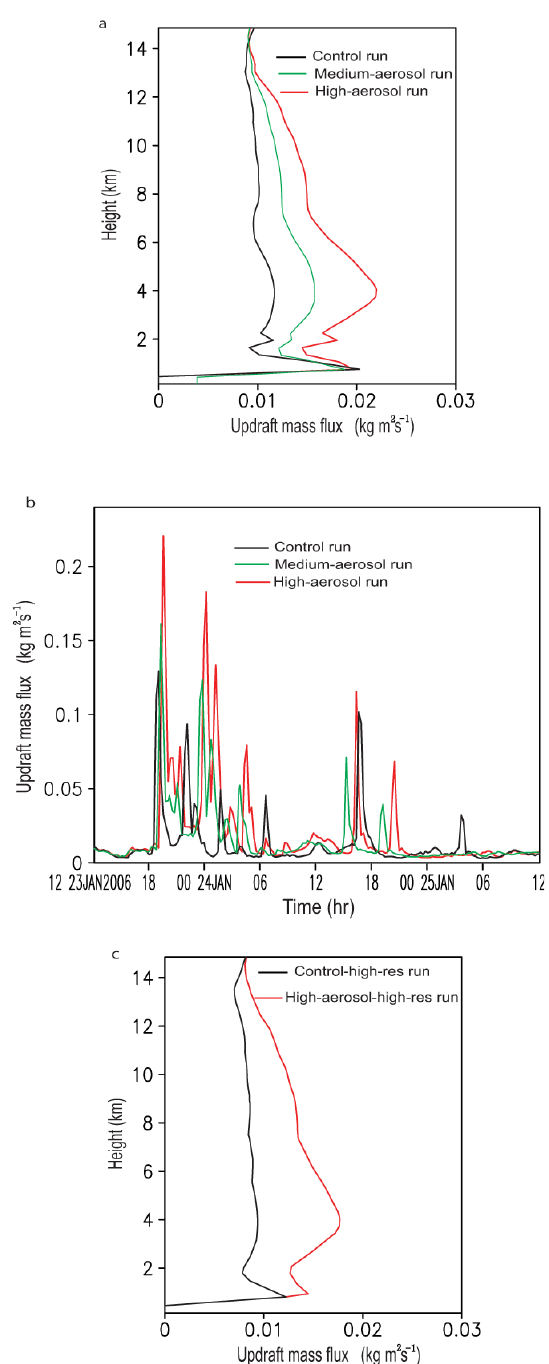
Fig. 2. (a) Vertical distribution of updraft mass fluxes and (b) time series of updraft mass fluxes, averaged over grid cells with positive vertical velocities. (c) As in (a) but for the control–high-res and high-aerosol–high-res